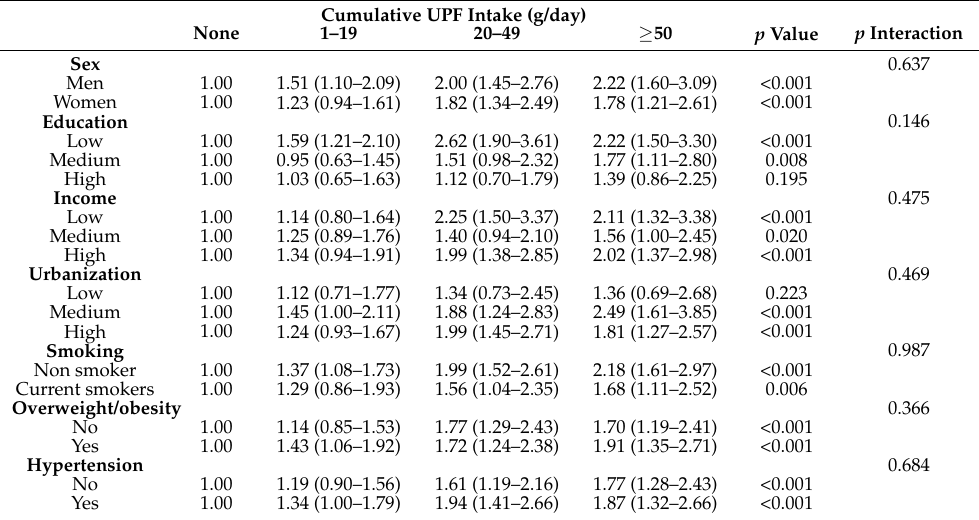
Table 4. Stratified analysis of the association between cumulative UPF consumption in 1997–2011 and diabetes by sample